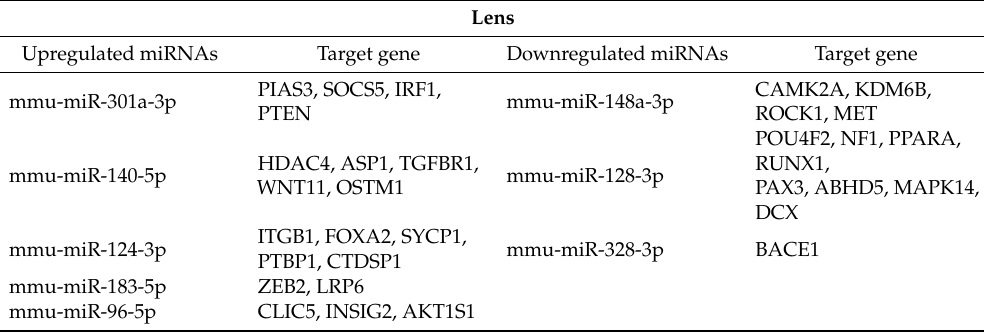
Table 10. The target genes predicted from the change in miRNA expression in the lens.